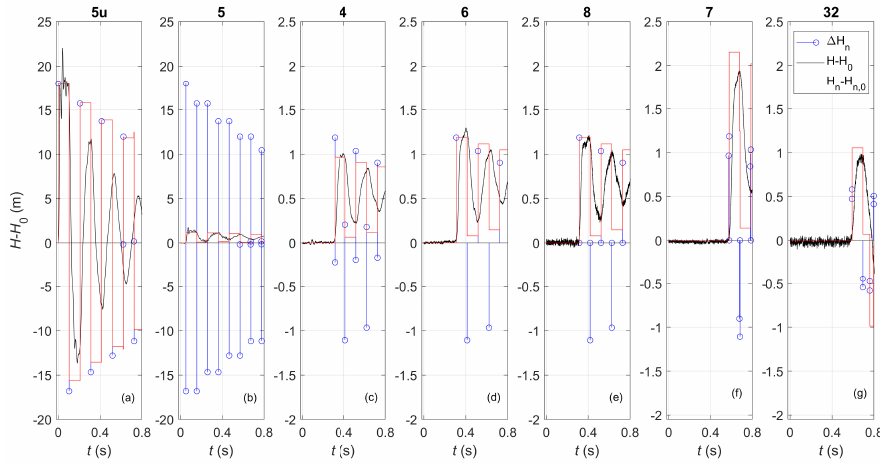
Figure 5. Test #1—experimental pressure disturbances, H − H 0 , vs. the impulse response function, ∆ H n (blue stems), and numerical reconstruction, H n − H n ,0 (red line), carried out by the Lagrangian model (LM) at measurement sections: ( a ) 5u; ( b ) 5; ( c ) 4; ( d ) 6; ( e ) 8; ( f ) 7; and ( g ) 32.